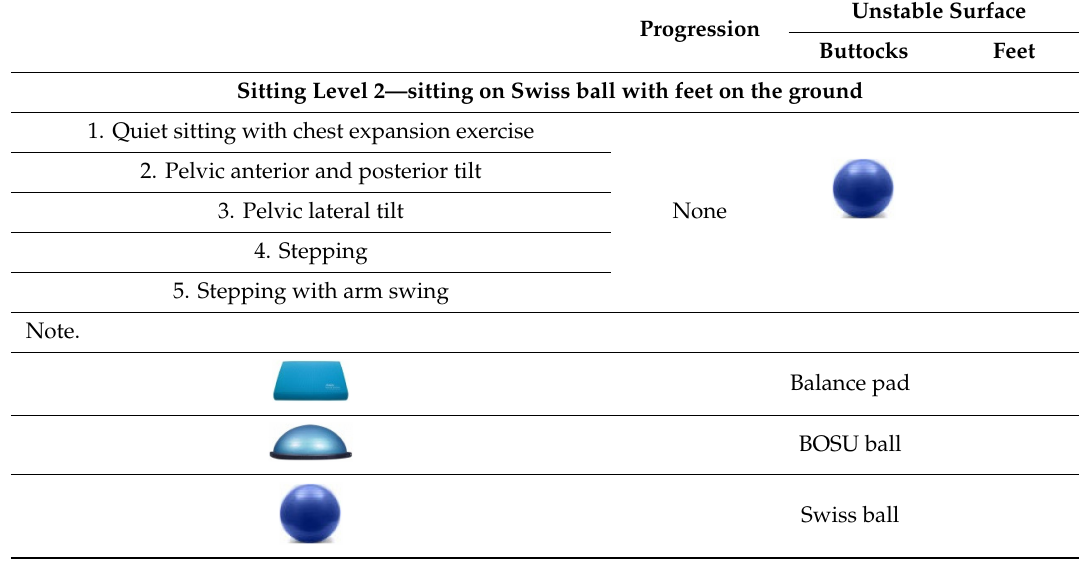
Sitting Level 2—sitting on Swiss ball with feet on the